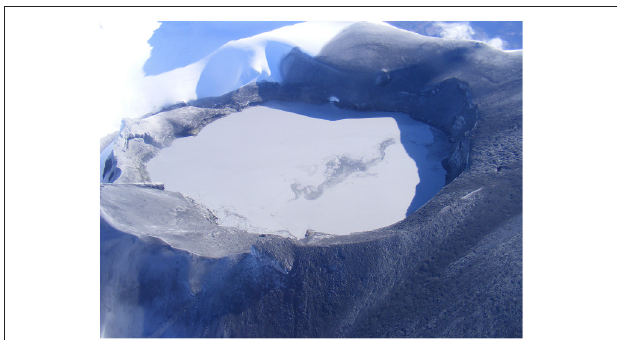
FIGURE 1 | View of Ruapehu’s Crater Lake (2518m in elevation) after the unheralded 2007 explosive eruption, taken on 26 Sept 2007. The black deposits surrounding the lake are dominated by hydrothermally altered material exploded from the lake floor, including up to 5% elemental S.